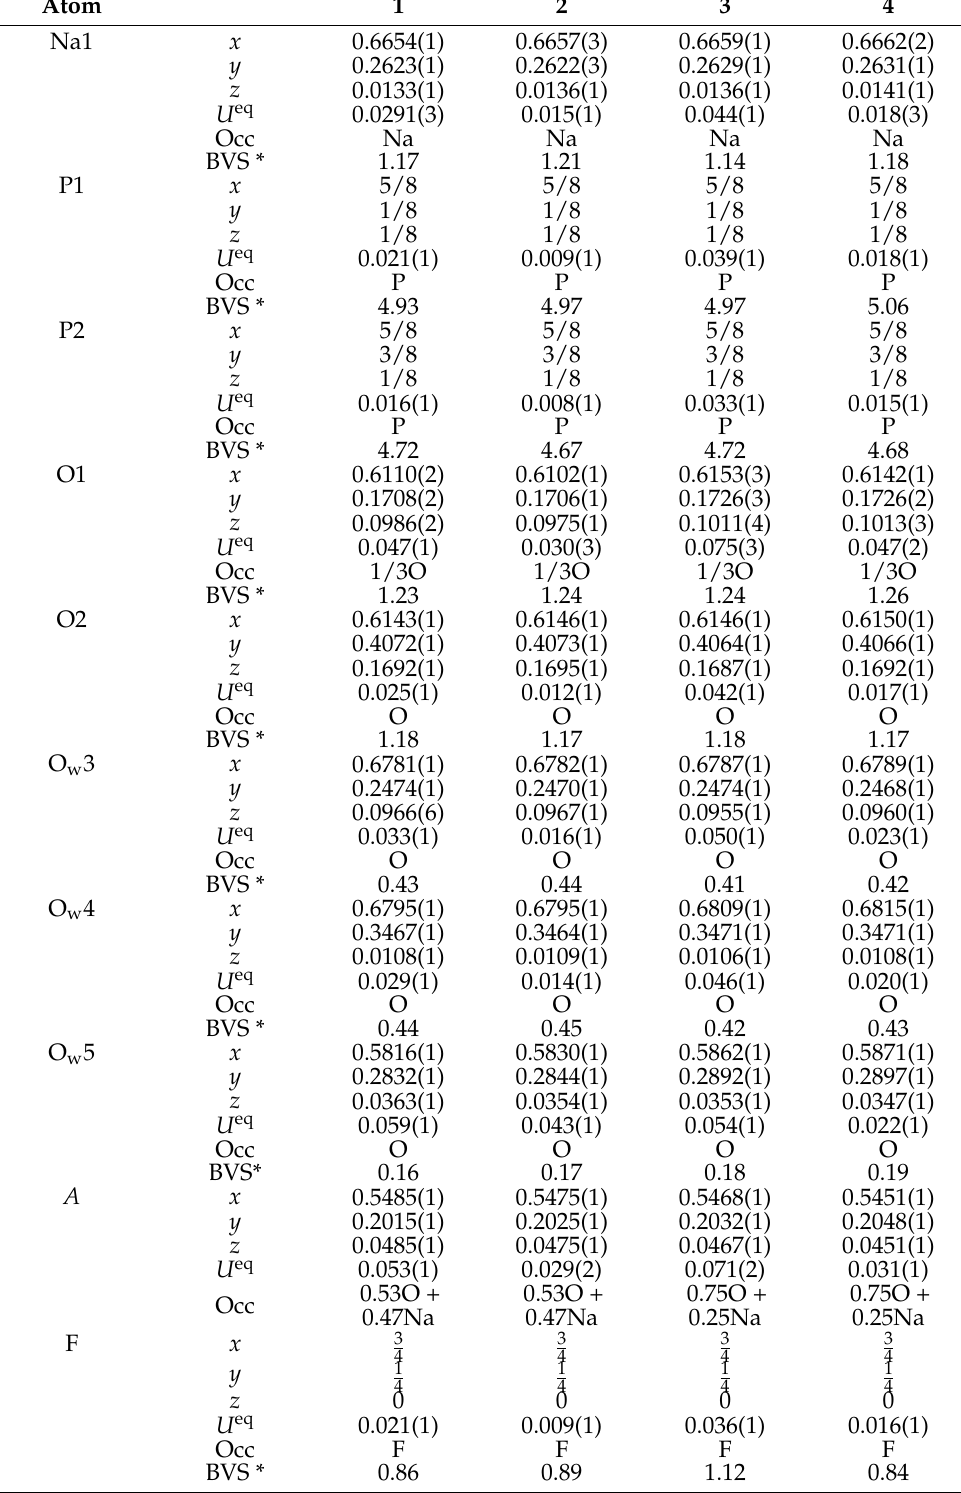
Table 2. Atomic coordinates, equivalent isotropic displacement parameters (Å 2 ), occupancies (Occ) and BVS (bond-valence sum) parameters for natrophosphate (1—RT, 2—100 K) and its synthetic analogue (3—RT, 4—100